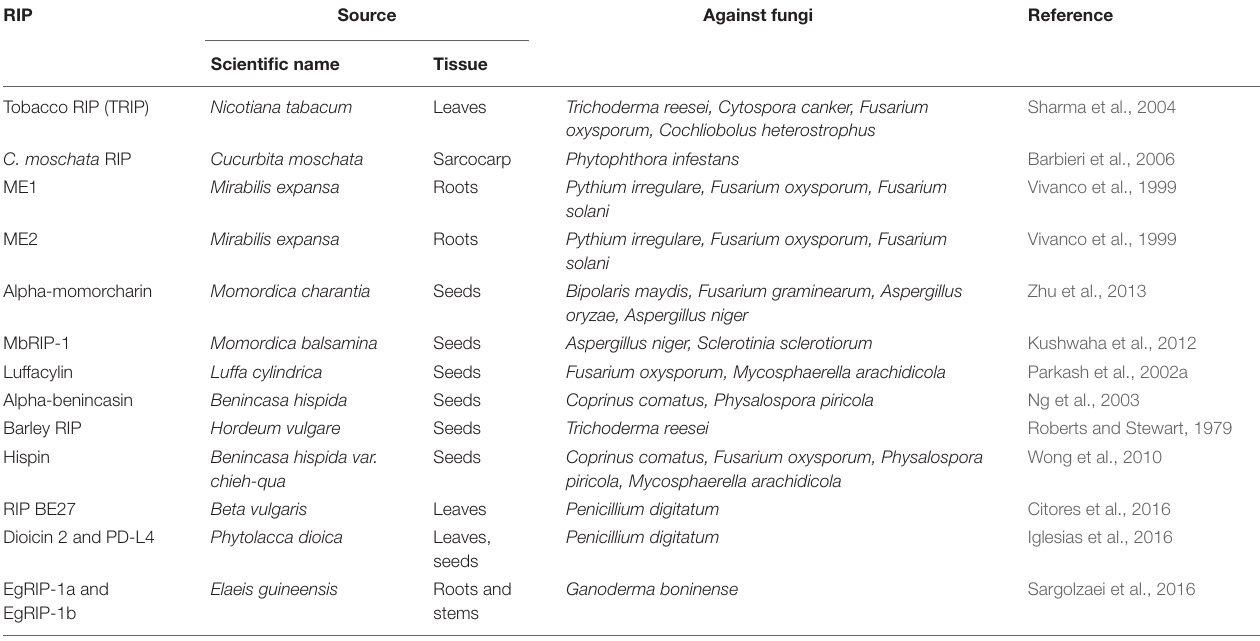
TABLE 2 | The role of different source RIPs in defense against fungi.